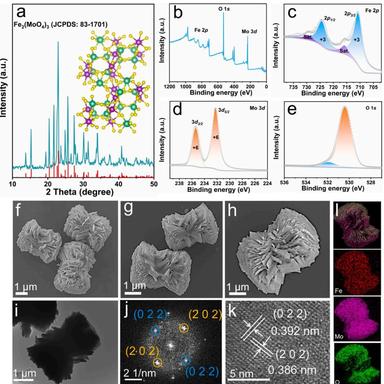
Structure characterizations of L-FMO. (a) XRD pattern and corresponding crystal structure. Survey spectrum (b) and high-resolution XPS spectra of Fe 2p (c), Mo 3d (d), and O 1 s (e). FESEM (f-h), TEM (i), FFT pattern (j), HRTEM (k) and EDS mapping images of L-FMO assemblies (l).